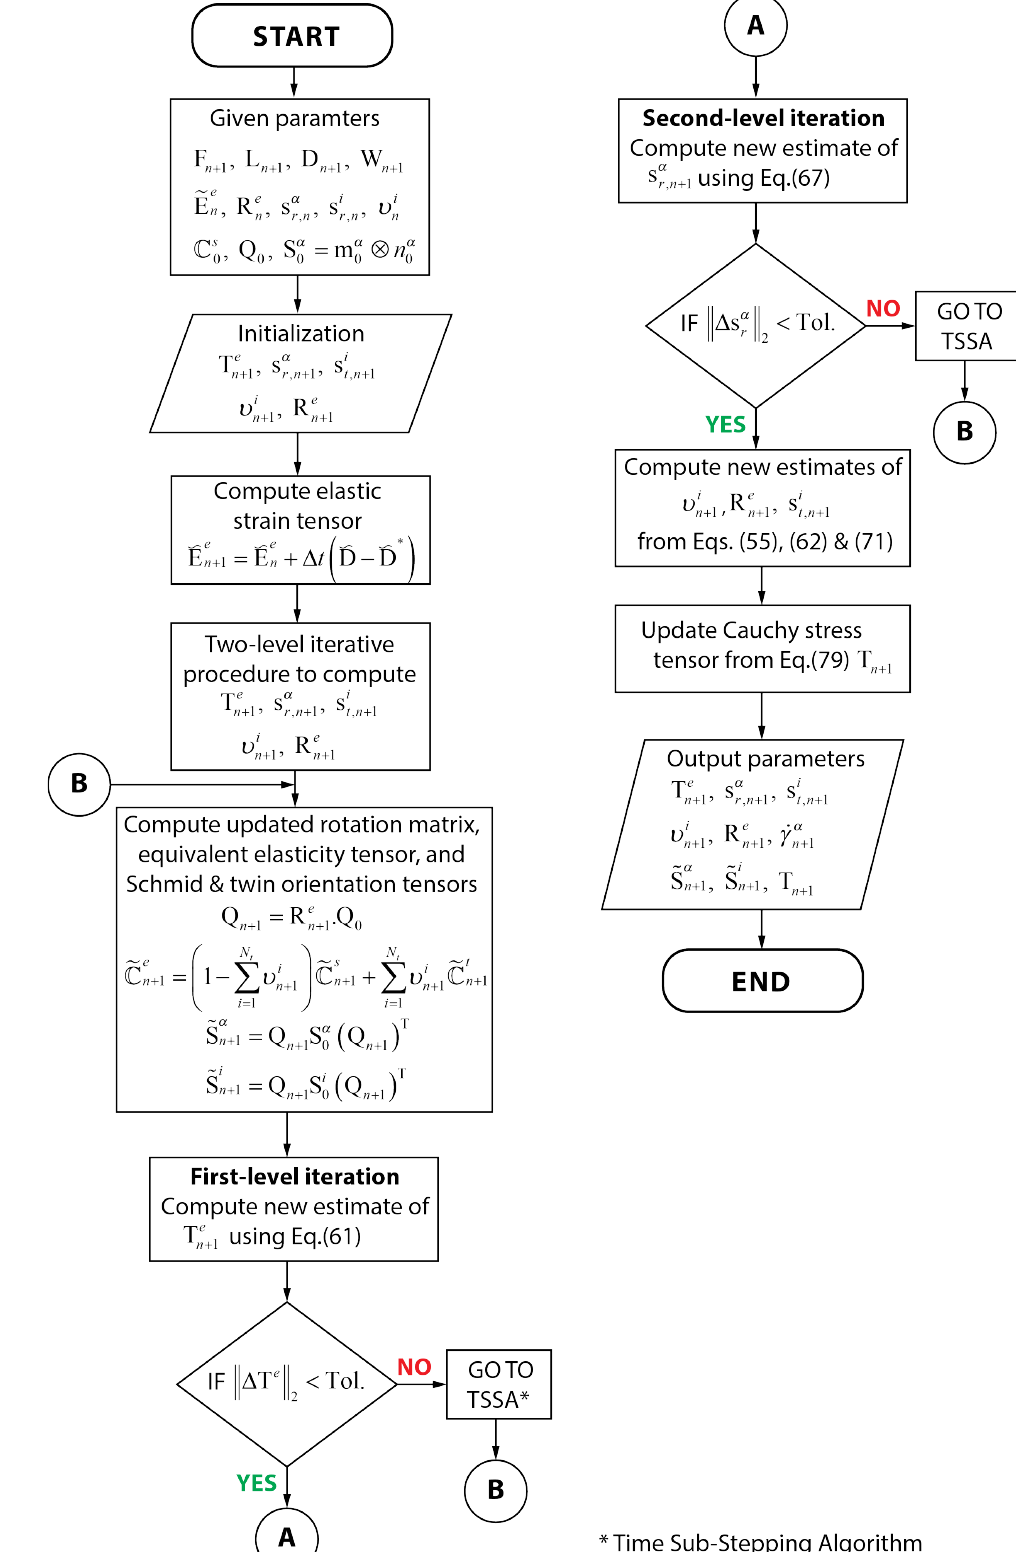
Figure 2. Numerical integration algorithm for crystal plasticity